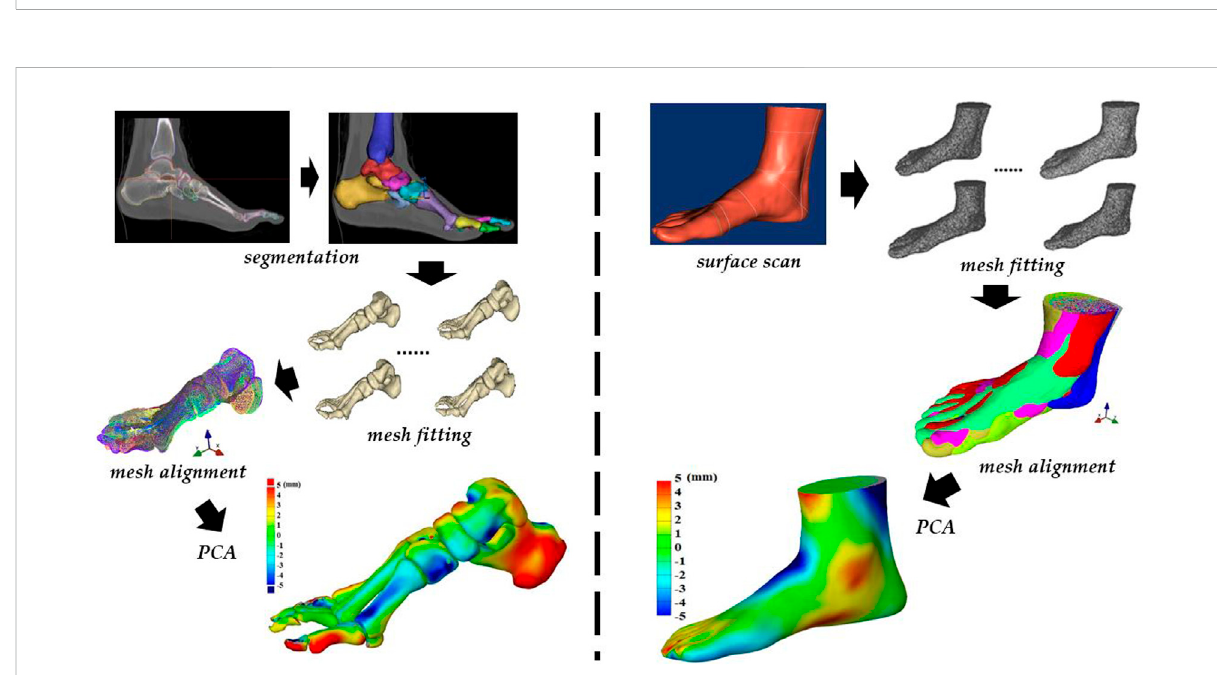
FIGURE 2 An outline of work fl ow in the statistical shape modeling (SSM) of foot bones (left) and surface (right) shapes. Steps of segmentation (bone) or surface scan (surface), mesh fi tting, mesh alignment, and